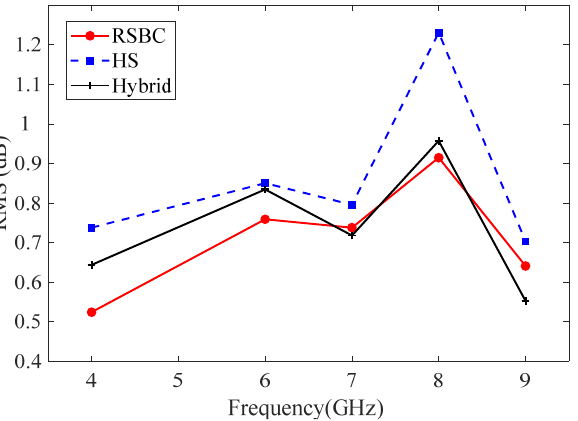
Figure 7. RMS as a function of operating frequency with size r=2.75 mm.